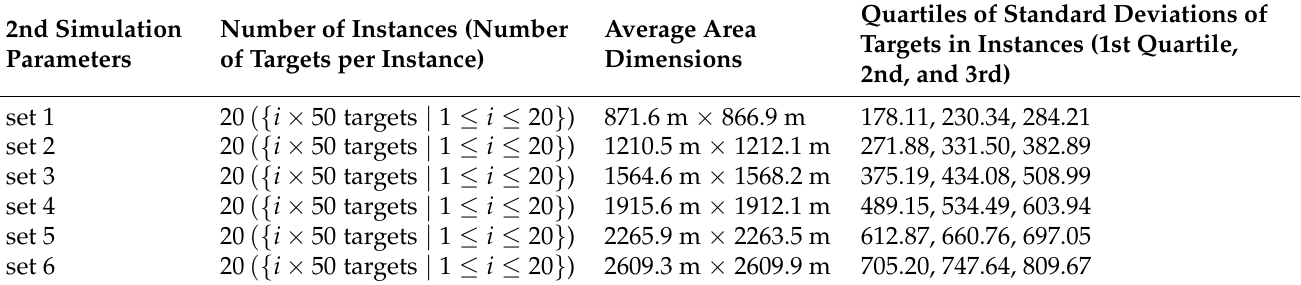
Table 2. Simulation parameters of second series of